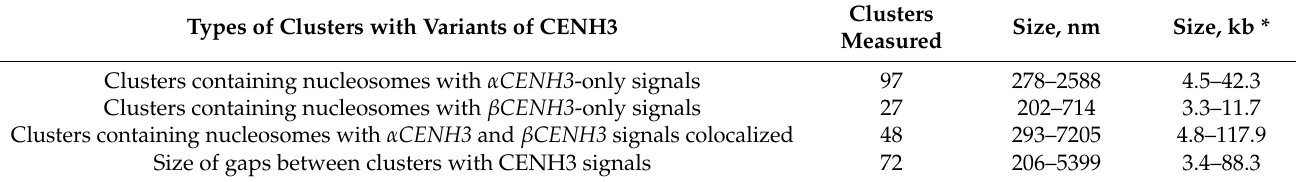
Table 2. Characteristics of chromatin fibers with CENH3 variants in the rye centromeric chromatin. Types of Clusters with Variants of CENH3